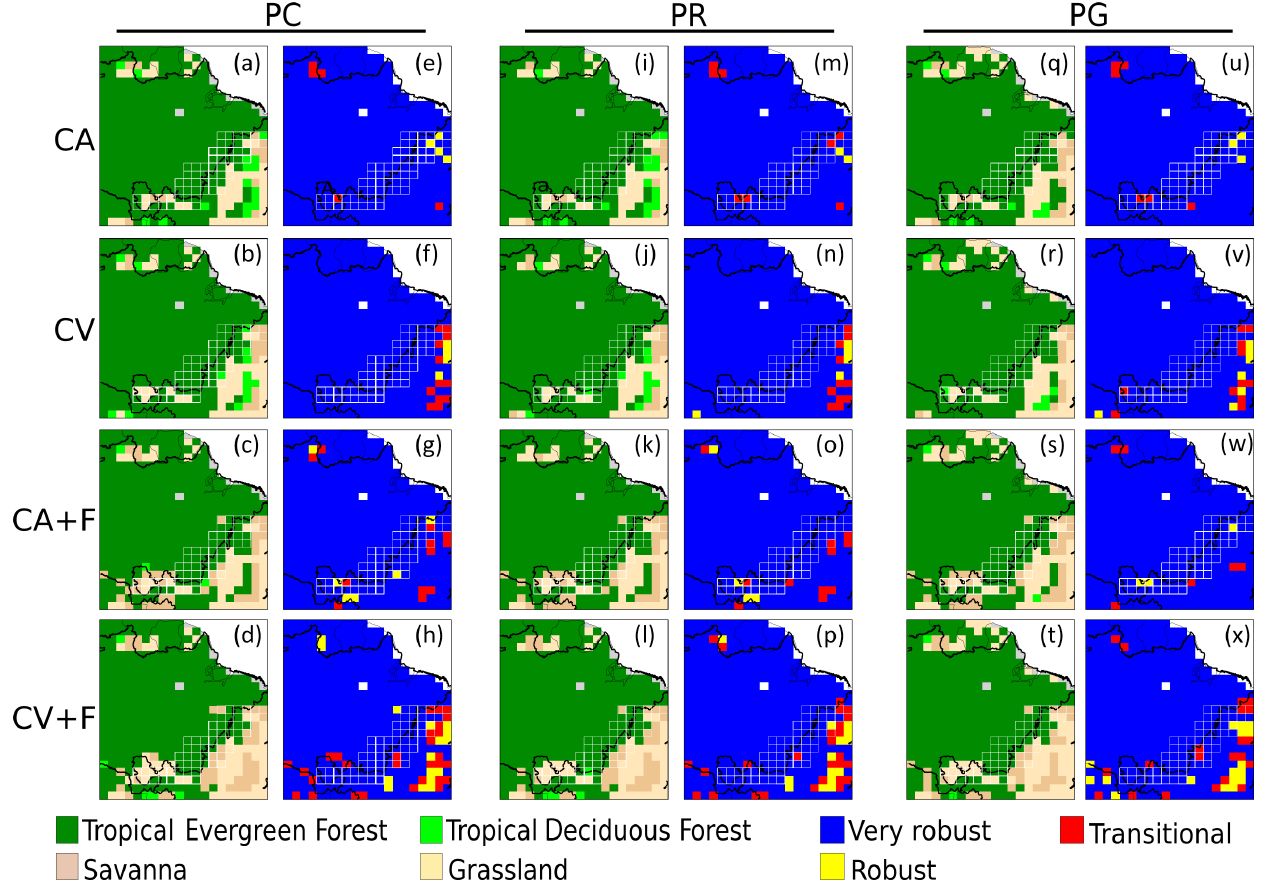
Figure 6. Results for the dominant vegetation cover simulated by INLAND for the different treatments (a–d, i–l, q–t) and a metric of variability in results (e–h, m–p, u–x) . Simulations are considered very robust if the dominant vegetation agrees in 9–10 of the last 10